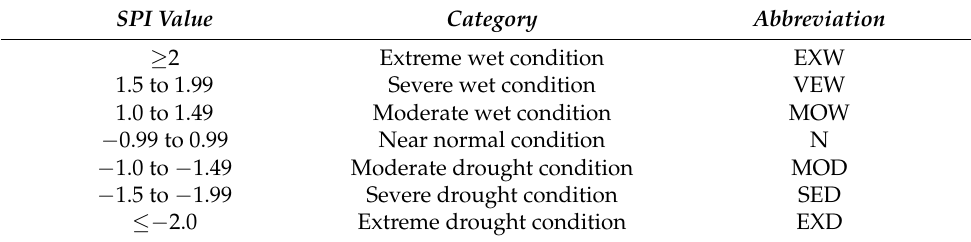
Table 2. SPI index classification system